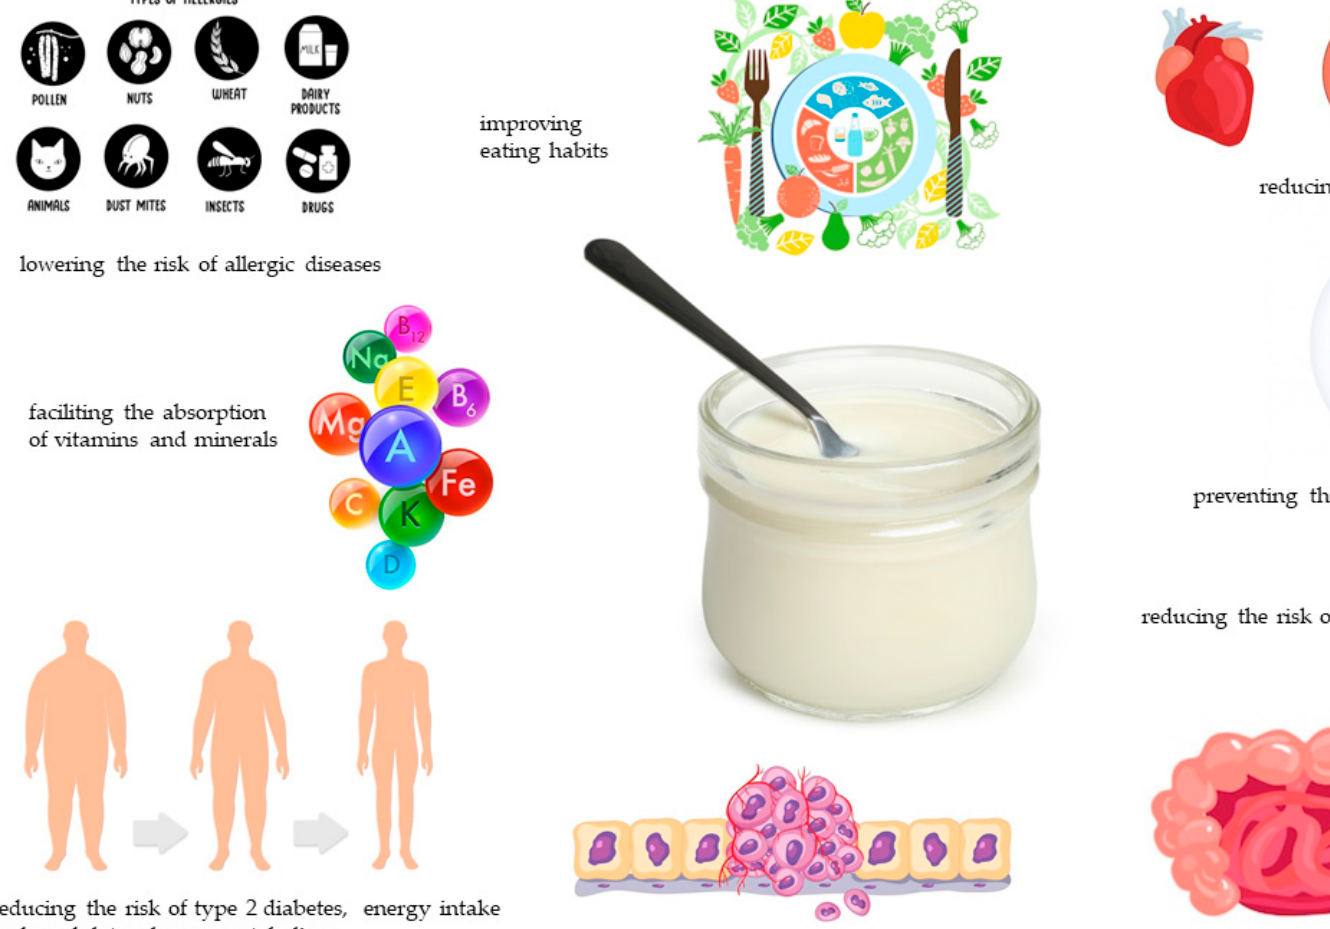
Figure 3. Therapeutic and preventing properties resulting from regular consumption of yoghurts.